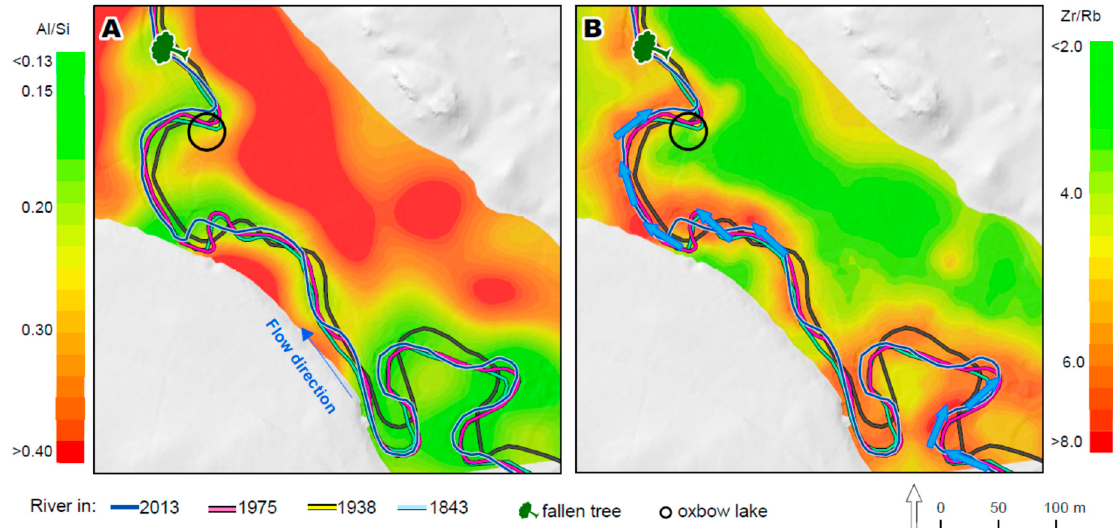
Figure 7. Maps of Al/Si ( A ) and Zr/Rb ( B ) ratios in the MS-West of Hradˇcany study area. Blue arrows indicate enhanced transport paths of overbank clastics as extrapolation of flow directions; they point to study areas with coarser overbank sediments, where gamma activity and XRF mapping produced markedly different results.